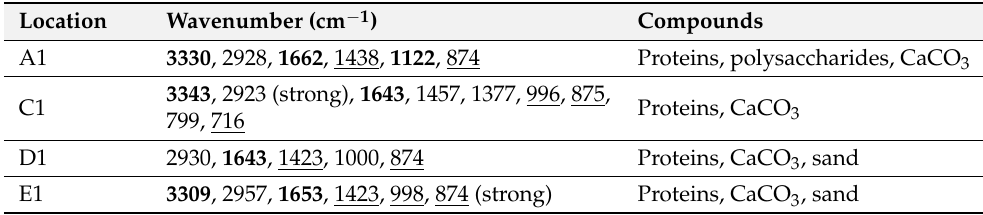
Figure 6. Microscopic images of sediment that was collected at the study location E1 under different magnifications. Table 2. Summary of wavenumbers in FTIR spectrum of particulate material collected over the distance of the study system at locations A1, C1, D1 and E1. Wavenumbers related to organic functional groups are in indicated in bold ; wavenumbers that are connected to inorganic functional groups are underlined.